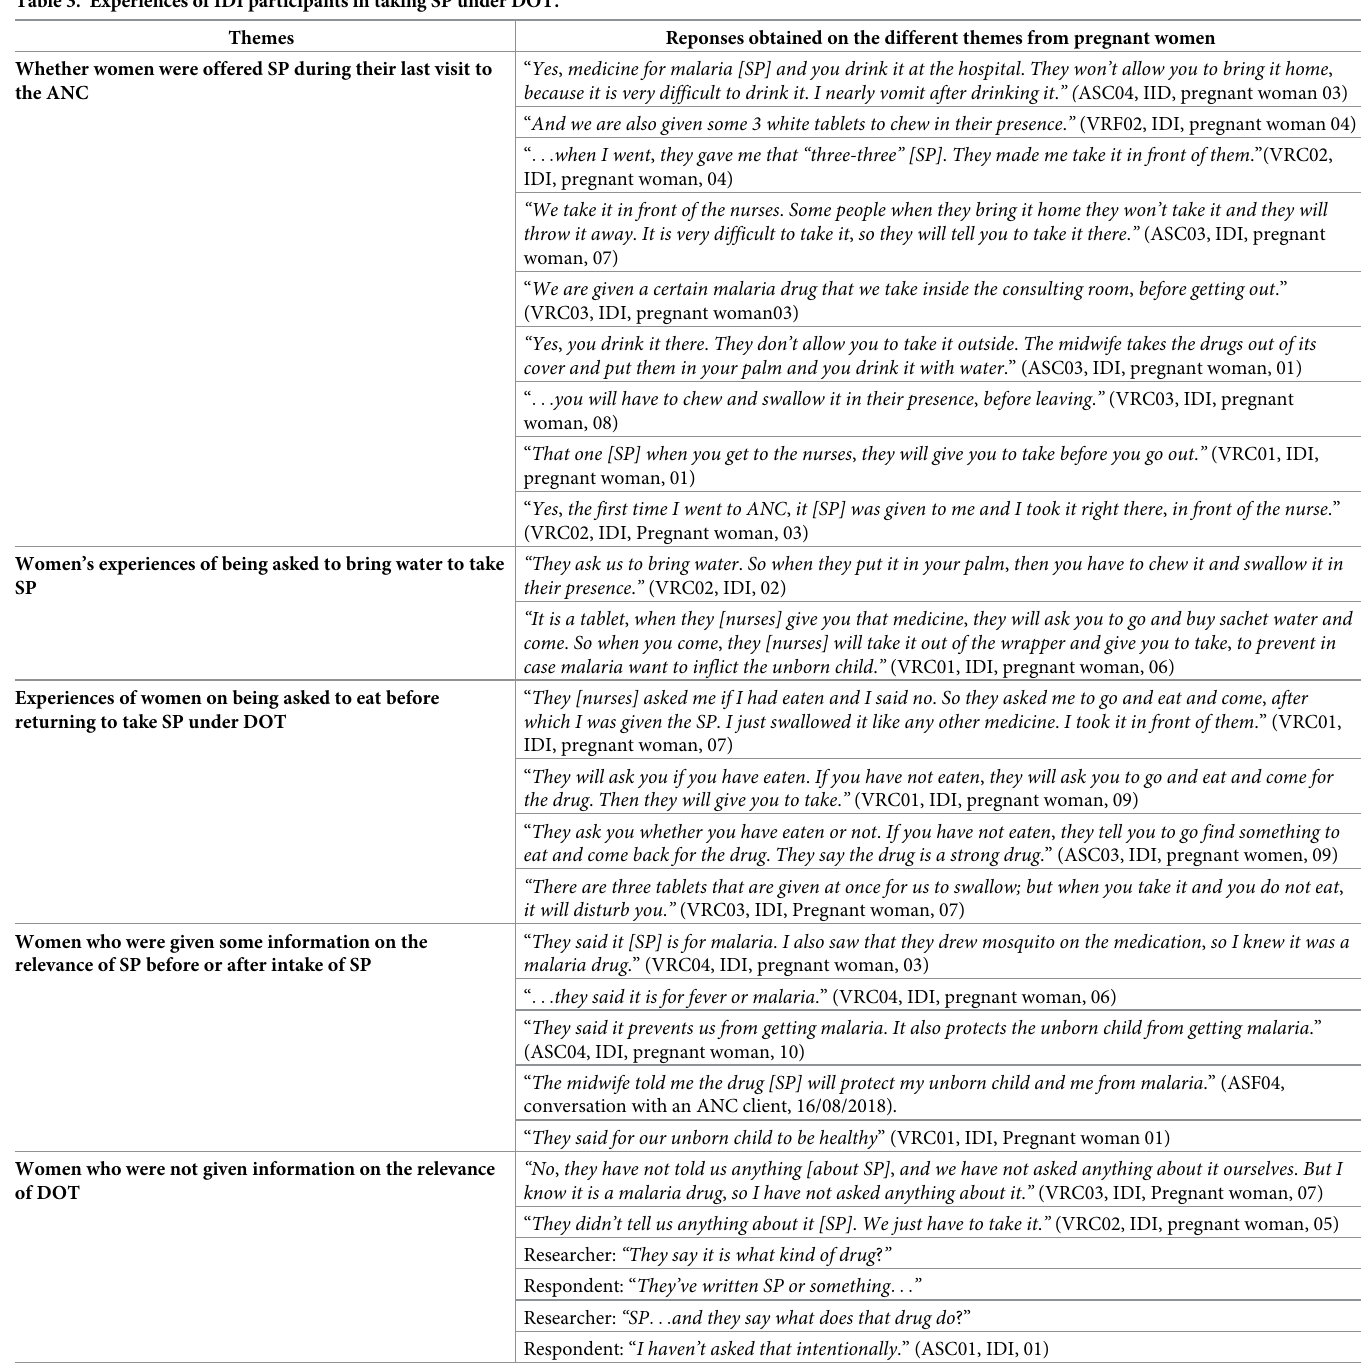
Table 3. Experiences of IDI participants in taking SP under